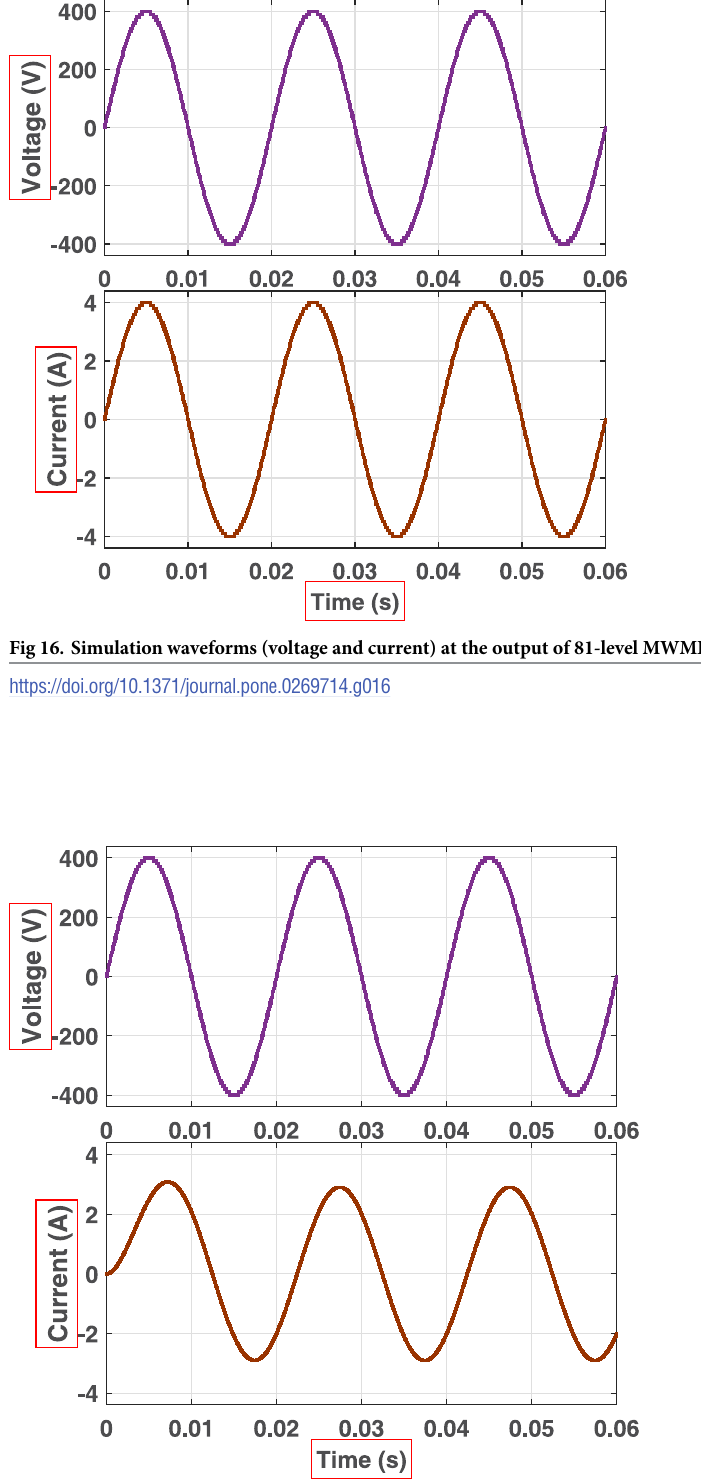
PLOS ONE | https://doi.org/10.1371/journal.pone.0269714 June 22,